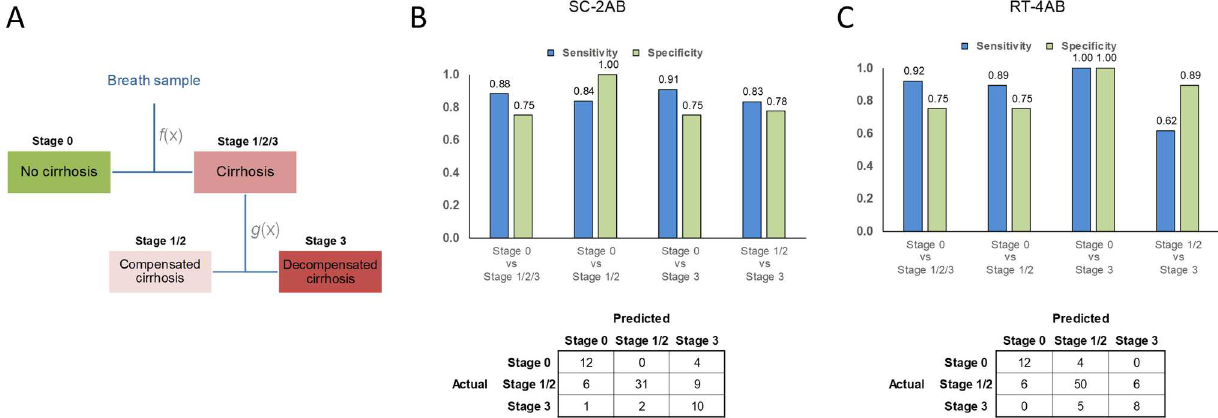
Fig 6. Performance of tandem classifier models. Tandem models were created by combining individual models for classification of cirrhosis and for classification of stage 3 (decompensated) disease. (A) In the tandem model, samples classified as cirrhosis using the former model would then be subsequently sub-classified into either compensated or decompensated disease using the latter. Models were trained and validated on a set of optimized samples, and performance validated on an independent set of samples using the exported tandem model. (B,C) The sensitivity and specificity (top) and confusion matrices (bottom) for tandem models for distinguishing between disease stages in independent validation cohorts are shown for subjects with (B) cirrhosis only (SC-2AB), or (C) on either cirrhosis or non-cirrhotic portal hypertension. (RT-4AB).